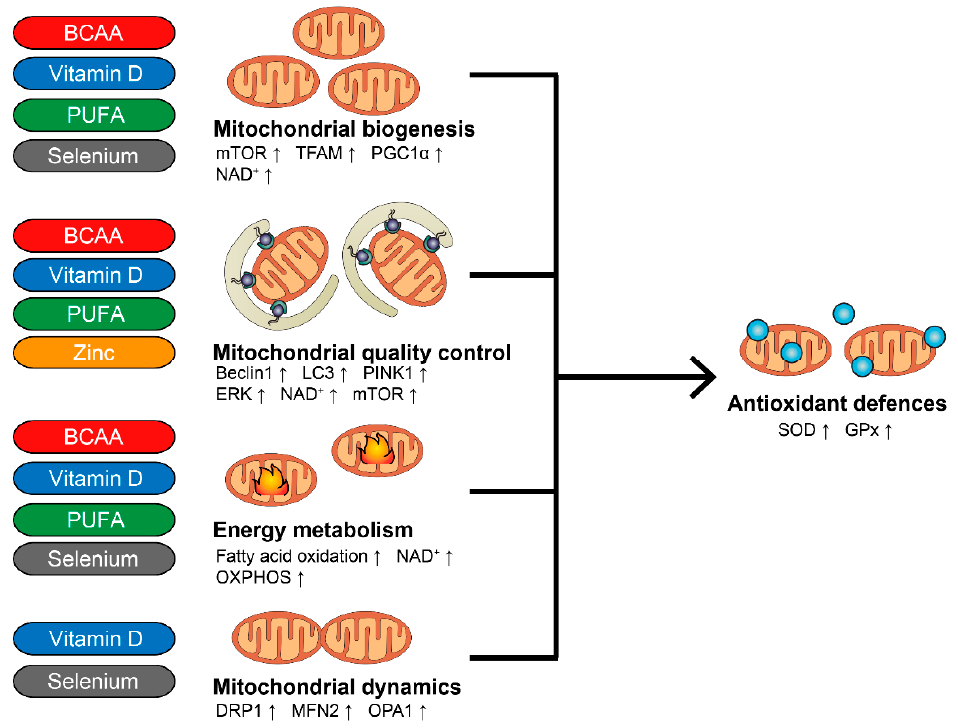
Figure 3. Mitochondrial pathways and molecular mediators affected by BCAA (in red), vitamin D (in blue), PUFA (in green), zinc (in orange), and selenium (in grey). ↑ : increased. A metabolite of leucine, beta-hydroxy-beta-methylbutyrate (HMB), has been shown